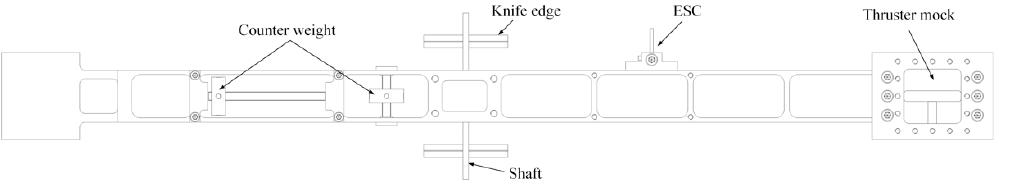
Figure 8. Schematic of two-dimensional balancing.